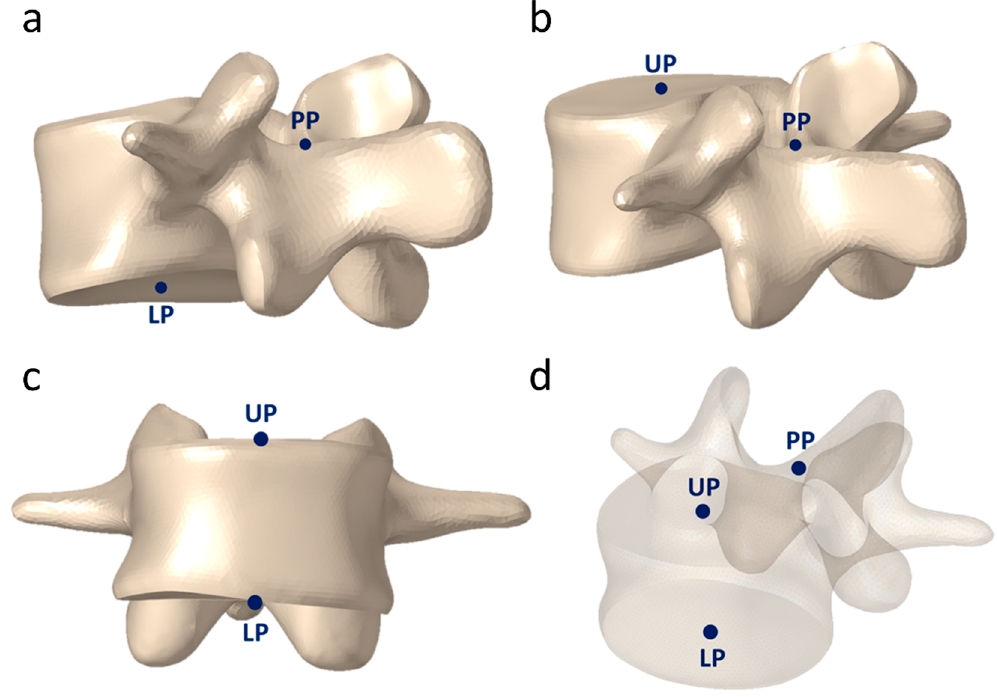
Figure A2. Markers on a vertebra ( a ) Posterior isometric view from below ( b ) Posterior isometric view from above ( c ) Front view ( d ) Transparent anterior isometric view, UP: Upper Point, LP: Lower Point, PP: Posterior Point.